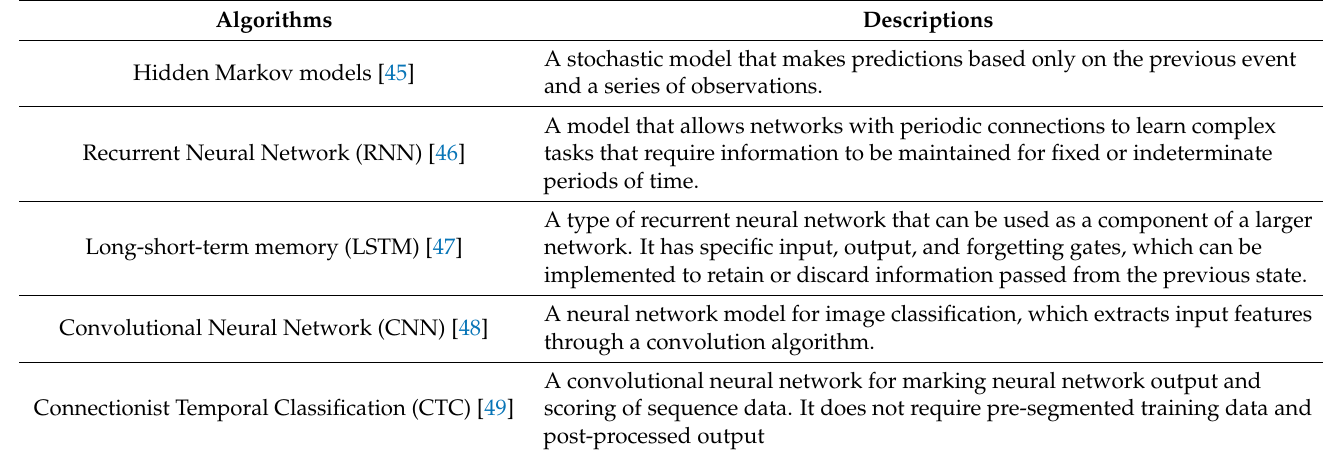
Table 2. Neural network algorithms used in nanopore basecaller.